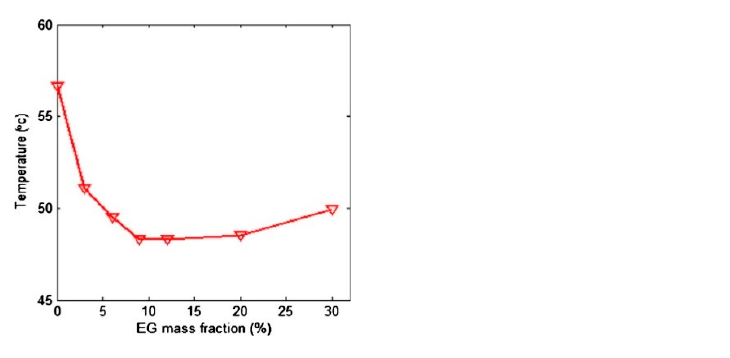
Figure 1. The volume-averaged battery temperature as a function of EG mass fraction.